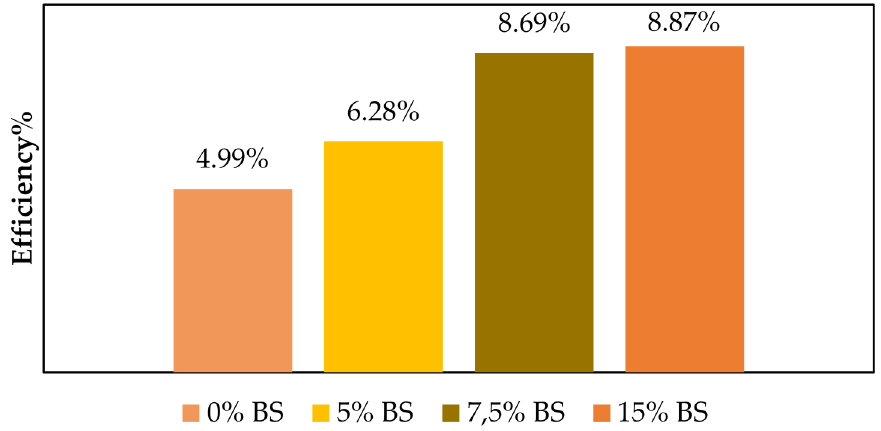
Figure 4. BFT efficiency test of BS-in-SOY agent with BS produced by Alcanivorax borkumensis SK2 . The concentration of BS diluted in soybean oil where 0%, 5%, 7.5% and 15% w/v.